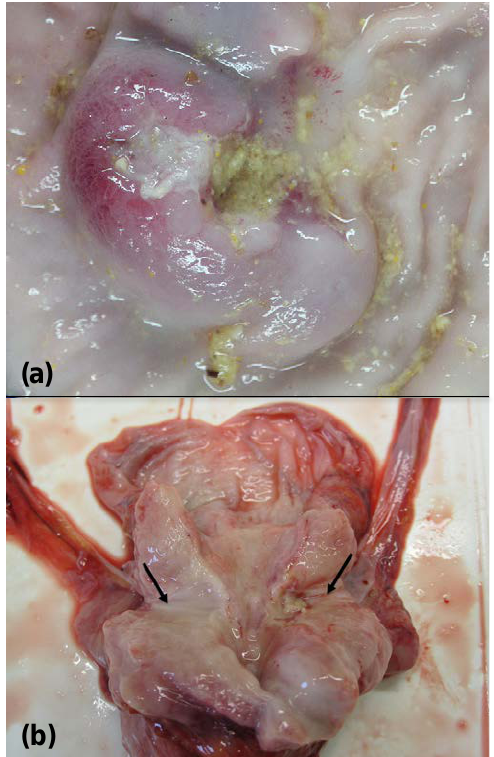
Figure 4. Light microscopic images of the gastric ( a – c ) and nodal tumor ( d – f ) of animal 1. (a) Neoplasm in the gastric wall is com- posed of densely cellular sheets of medium-sized to large lympho- cytic round cells admixed with infiltrating and residual small mature lymphocytes. (b) Membranous co-expression of CD20 and (c) CD3 in the majority of lymphocytic neoplastic cells is shown. (d) The DLBCL in the pancreaticoduodenal lymph node is composed of monomorphic medium-sized to large tumor cells with rare mature lymphocytes and sparse collagenous stroma. (e) Almost all lympho- cytic cells expressed CD20. (f) CD3 was only expressed by a small fraction of cells. HE staining ( a , d ); IHC with SABC method and chromogen DAB ( b , c , e , f ); scale bar = 50µm. HE is hematoxylin and eosin; IHC is immunohistochemistry; SABC is streptavidin– biotin complex; DAB is diaminobenzidine